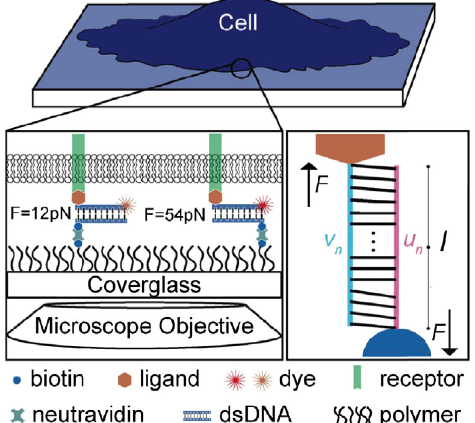
FIG. 1. Schematic of multiplex TGT experiment. Cells cultured are presented with two types of TGTs simultaneously. TGTs are conjugated with the tripeptide RGDfK, which binds to integrin receptors expressed on the cell surface. Each type of TGT is also labeled with a distinct fluorophore, on the top strand, and anchored to the surface through a biotin-neutravidin linkage. The inset shows the DNA tether under tension of magnitude F applied across l base pairs in a shear force